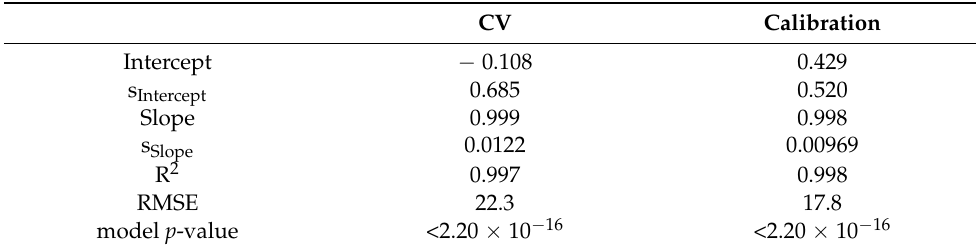
Table 4. CV and calibration regression line parameters.